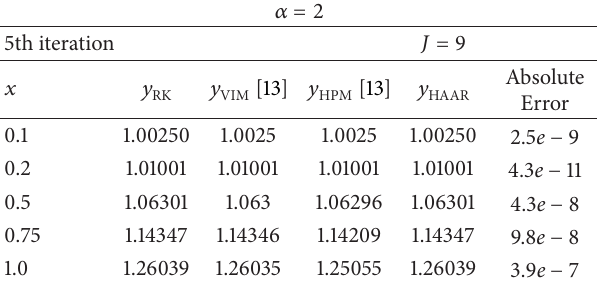
Table 3: Double-hump situation: comparison of solutions by the Haar wavelet-quasilinearization technique 𝑦 and level of resolutions 𝐽 = 9 with numerical methods [13] and numerical solution based on the fourth-order Runge-Kutta.